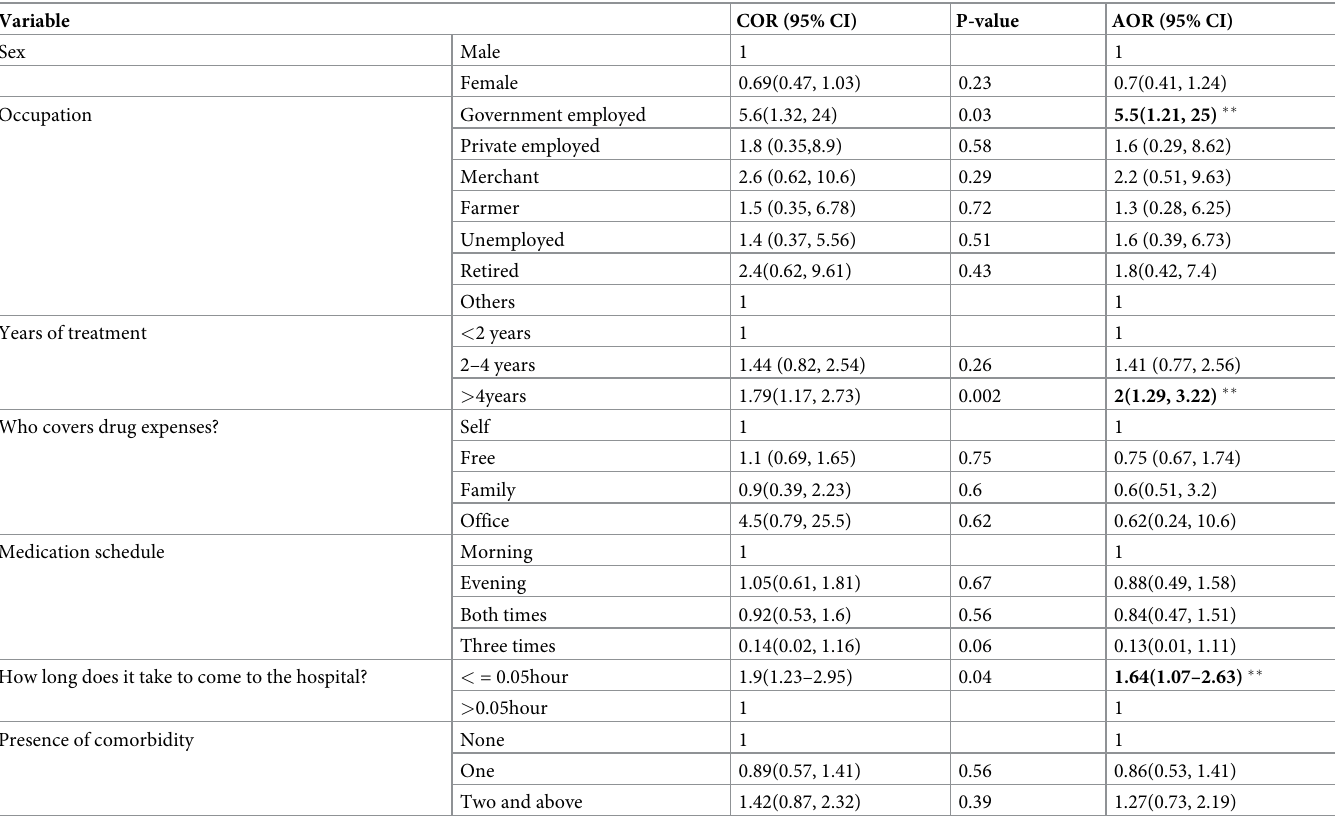
Table 3. Factors affecting Knowledge of HTN among Hypertensive patients in Gondar public health facilities, North West Ethiopia, 2019.